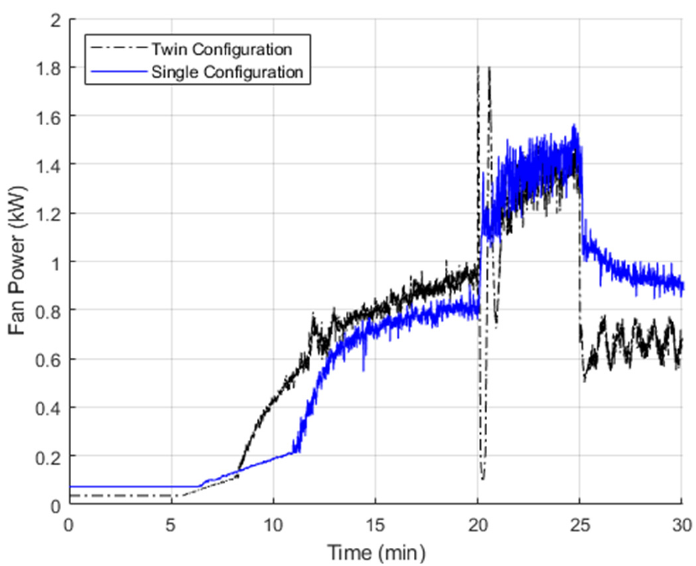
( b ) Figure 5. Coolant temperature (left axis) and fan/pump shaft speeds (right axis) with respect to time for ( a ) twin- and ( b ) single-radiator configurations. The energy efficiencies of the two configurations were studied based on the radiator fan power consumption. The coolant pump used for the experiment was oversized and used three-phase AC power. Figure 6 shows the net power consumption by all active fans during the test runs. The data, derived using the empirical relations, show that both cases